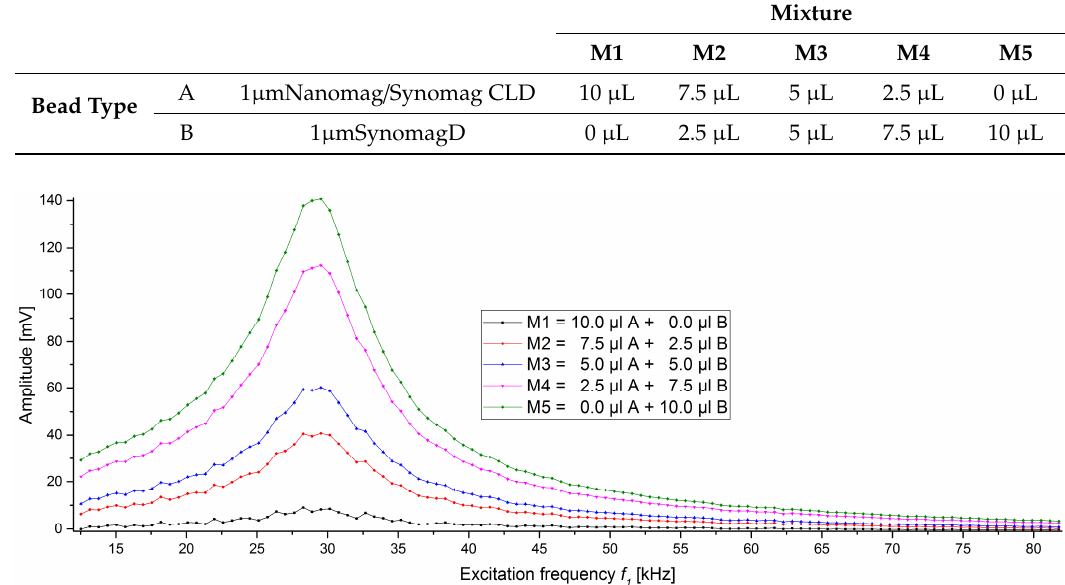
Figure 4. Amplitudes of frequency scans of 5 different samples containing different ratios of two beads (see Table 2). The total bead solution was always 10 µL in 400 µL of distilled water. Shown are the mean and standard deviations (within marker size).